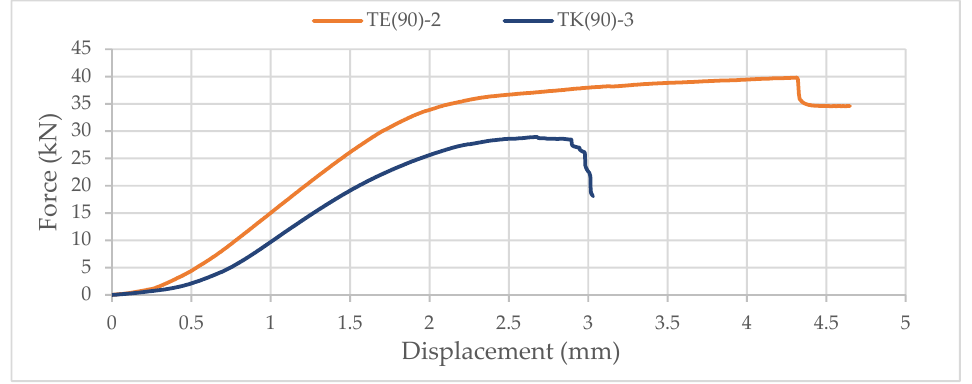
Figure 25. The force-displacement curve for compression perpendicular to the grain of samples with circular cavities in the direction of the stronger axis.